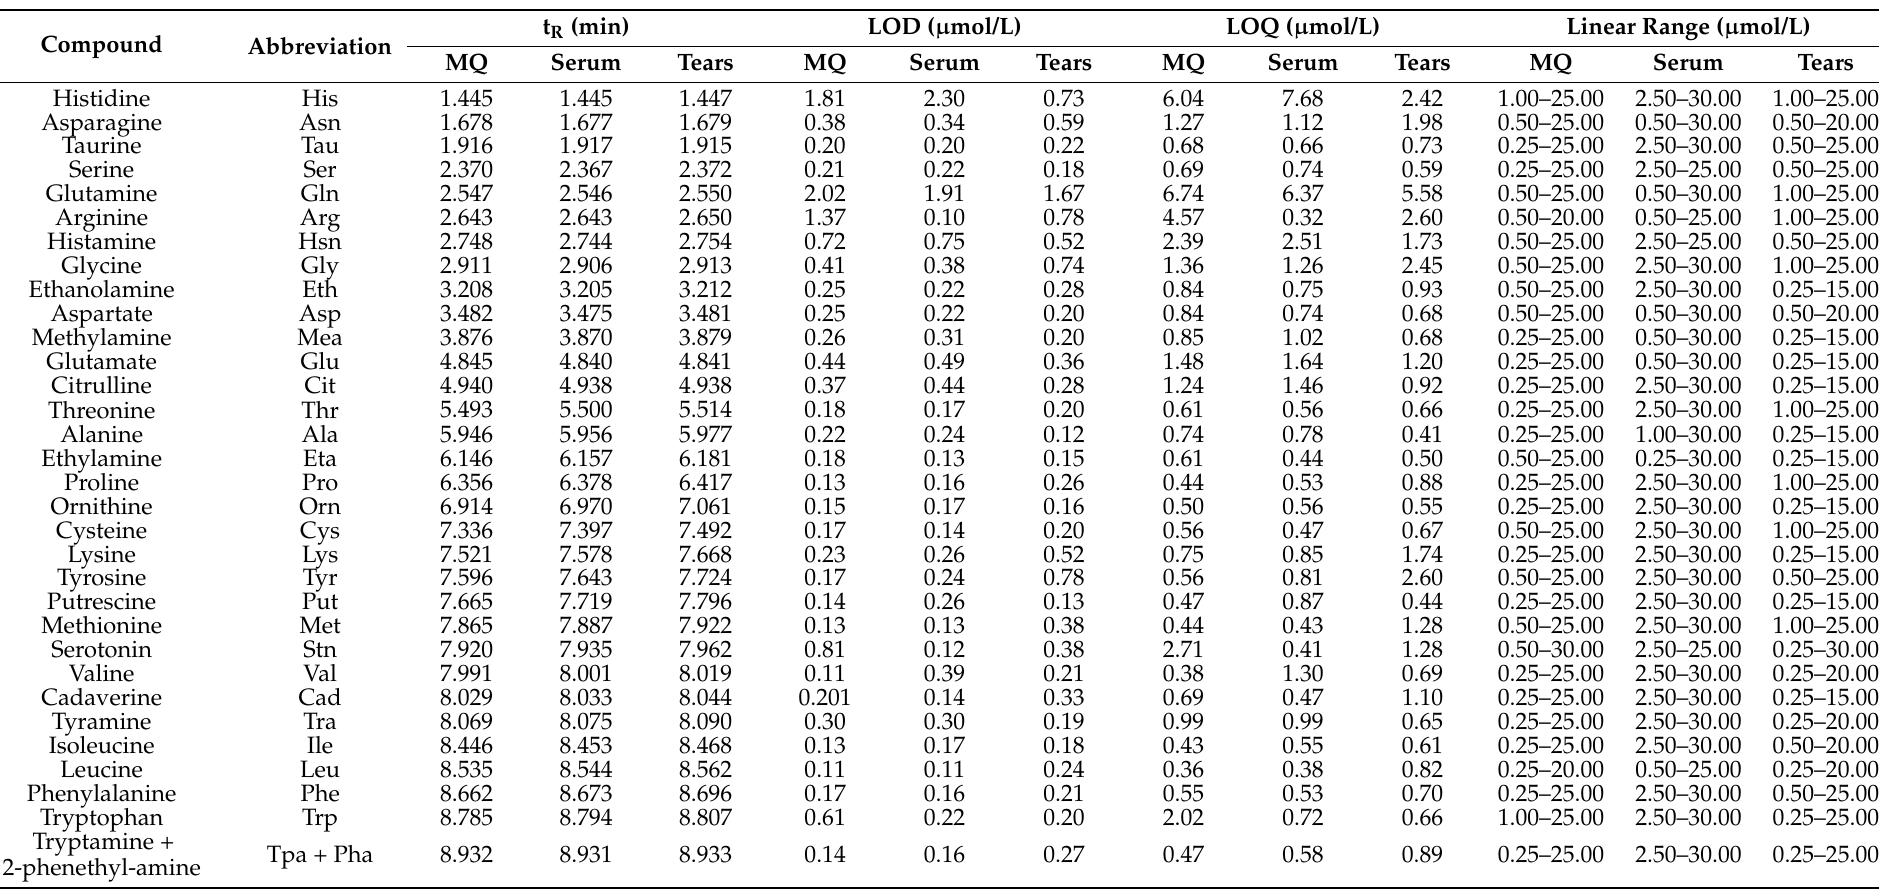
Table 1. Calibration parameters of the analyzed molecules in different matrices obtained with UHPLC-UV analysis. t R : retention time, MQ: MilliQ water, LOD: limit of detection, LOQ: limit of quantification. The data represent the mean value of three technical